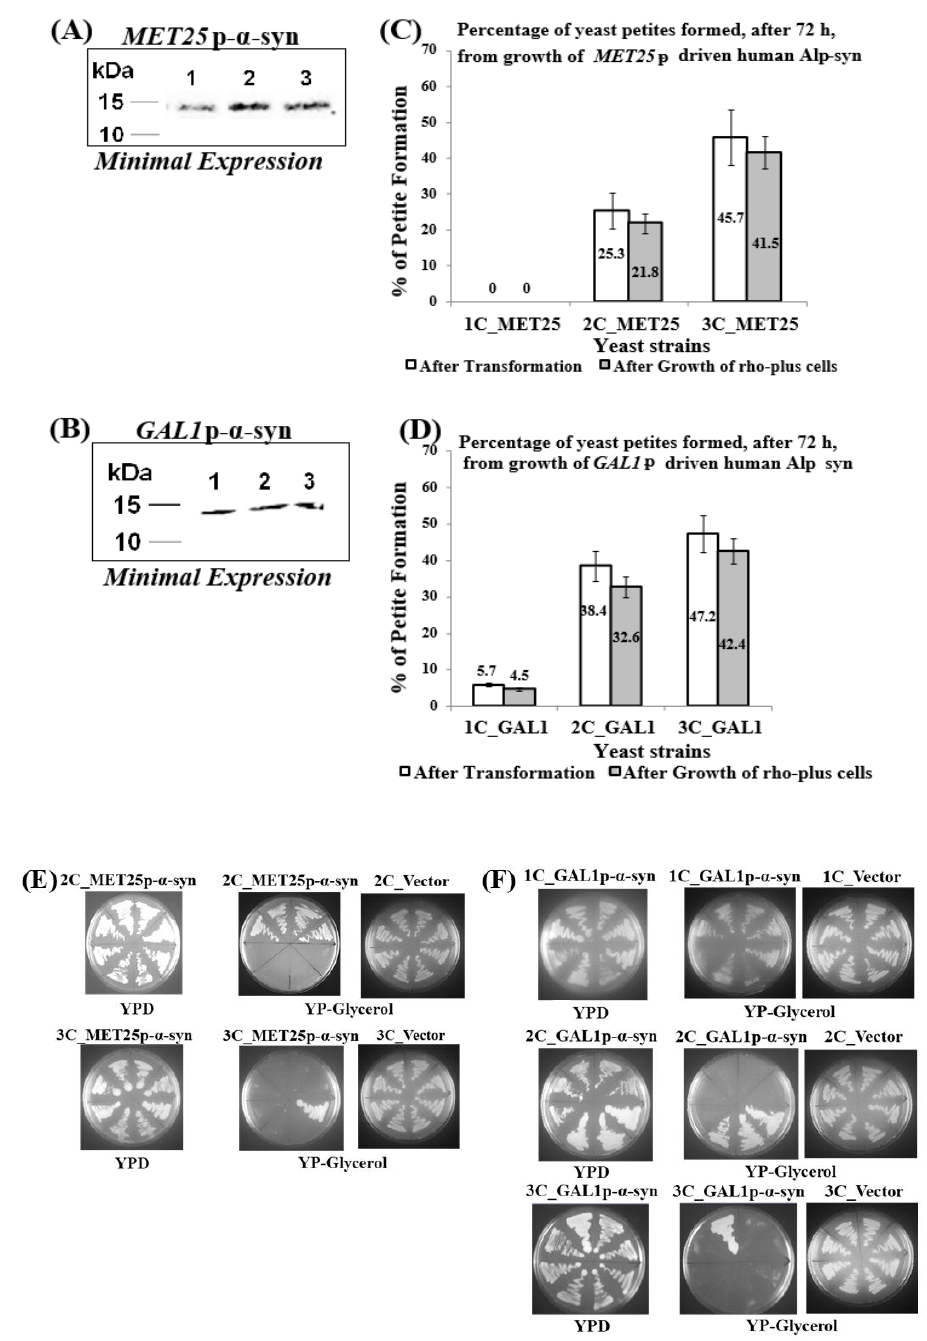
Figure 1. Petites obtained after minimal expression of α -syn from the MET25 or GAL1 promoter. ( A , B ) Western blot analyses of cells expressing 1 to 3 copies of α -syn protein from either MET25 p ( A ) or GAL1 p ( B ) The blots were probed with an antibody that recognizes α -syn protein (Proteintech, 10842-1-AP); ( C , D ) The percentage of petites formed (in cells containing 1–3 copies of α -syn under the control of MET25 p / GAL1 p) from a total of 50 transformants (non-shaded bars) or in 200 cells obtained. The data represent the mean ± S.D. of three independent experiments. Post Hoc Newman-Keuls test was carried out after a significant ANOVA test, indicating a significant di ff erence p < 0.01 in petites formed between cells expressing 1opy and 2 or 3-copies of α -syn. ( E , F ) Representative pictures of growth of yeast cells harboring 1-copy (1C), 2-copies (2C), and 3-copies (3C) of the human α -syn gene, under the control of MET25 p ( E ) and GAL1 p ( F ), on complete medium solid agar plates that contained either glucose (YPD; plates 1) or Glycerol (YP-glycerol; plates 2). ‘Vector’ represents cells that contain empty plasmid(s), with no α -syn gene, grown on YP-glycerol (plates